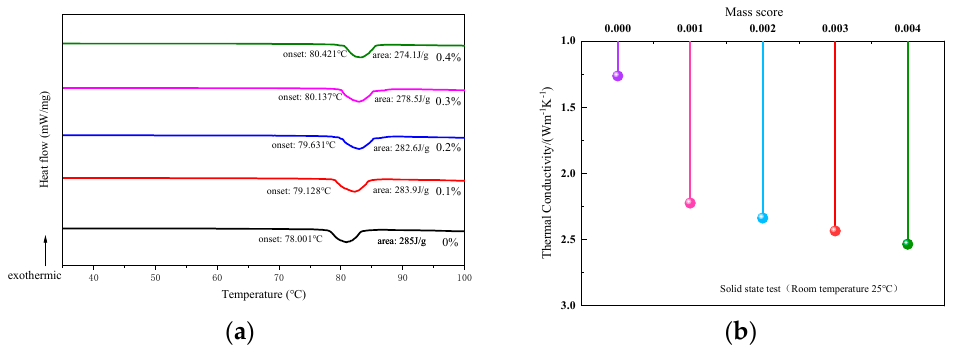
Figure 6. ( a ) DSC test chart; ( b ) Hotdisk test chart.